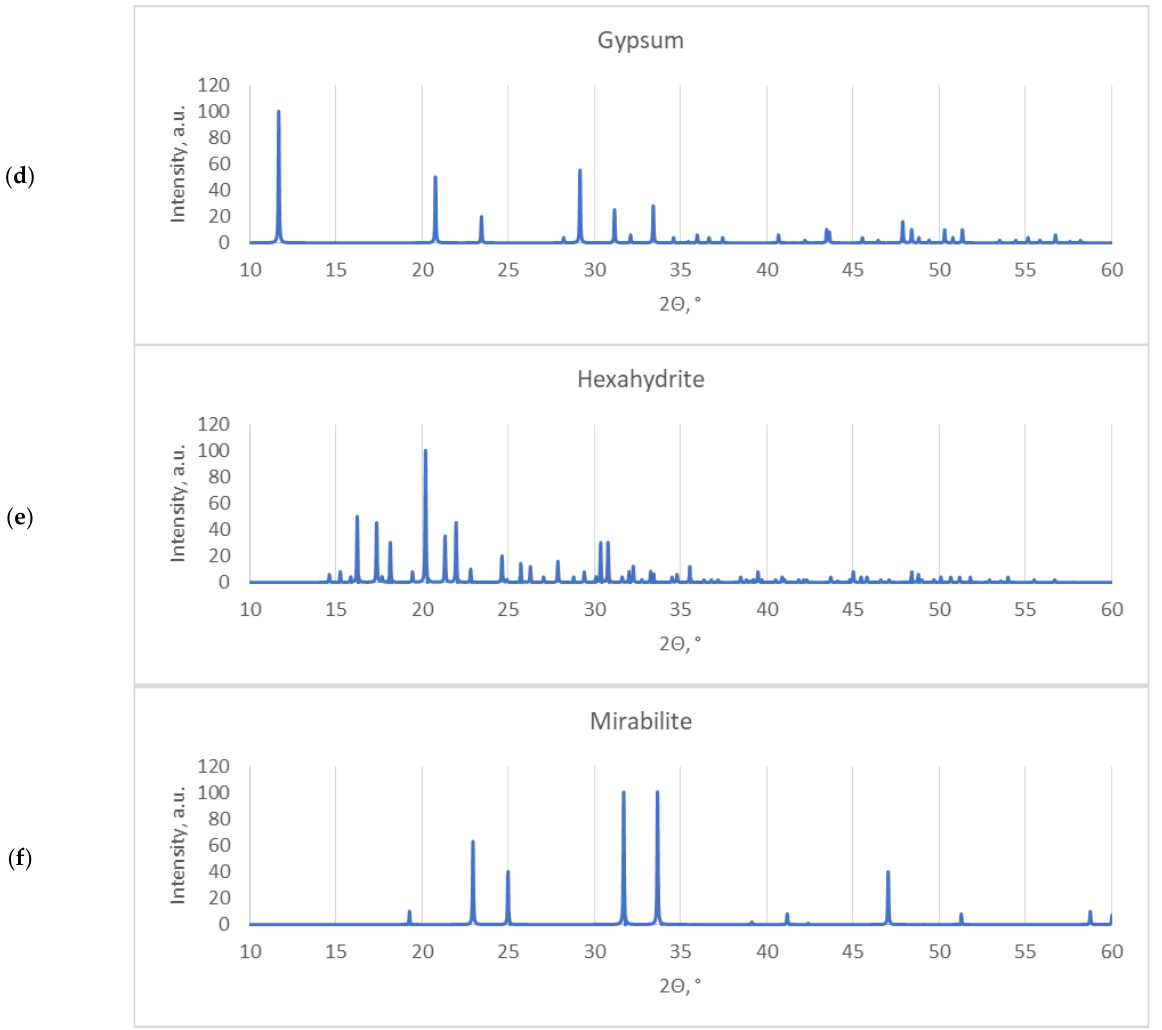
Figure 1. XRD diffractograms of the ( a ) S1-S5 salts and ( b – f ) respective XRD patterns from the crystallographic database.